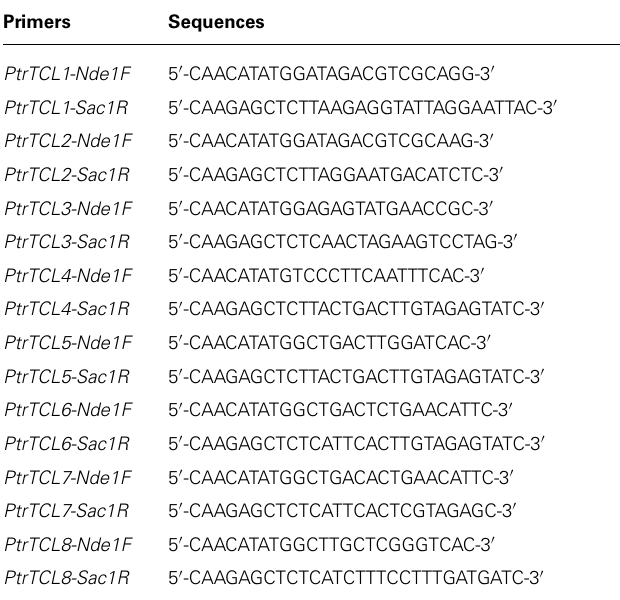
Table 1 | Primers using for poplar R3 MYB gene cloning and expression